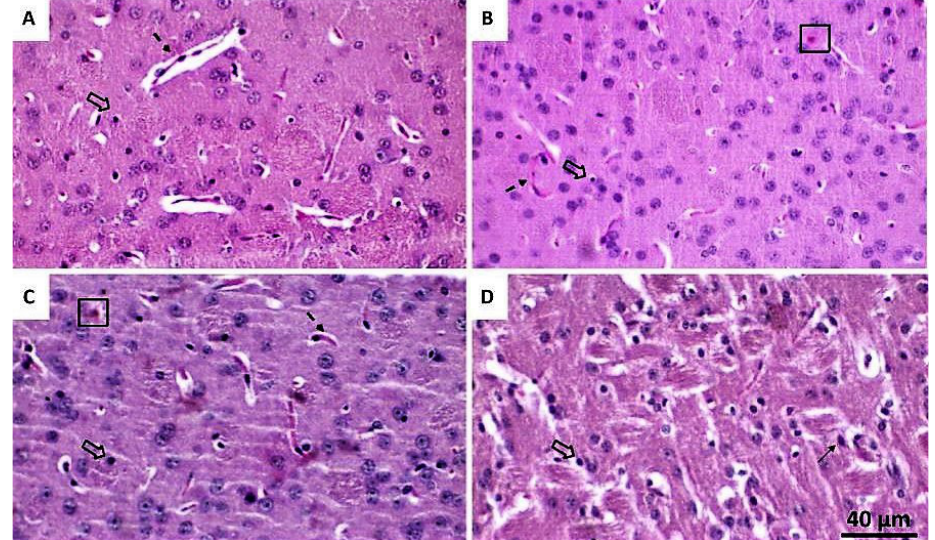
Figure 4. Representative photomicrographs of histological sections stained with Hematoxylin- eosin (HE) showing brain tissue in the striatum—CPu. ( A ) represents the group 6-OHDA/saline; ( B ) represents the group 6-OHDA/ BV 0.01 mg·Kg −1 ; ( C ) represents the group 6-OHDA/ BV 0.05 mg·Kg −1 ; ( D ) represents the group 6-OHDA/BV 0.1 mg·Kg −1 . Dashed arrows point to blood vessels, thick arrows point to oligodendrocytes, squares highlight necrotic neurons and fine arrows point to healthy neuron. Magnification of 400×. The qualitative analysis of TH expression showed that the animals from the 6- OHDA/saline group presented a reduction in the number of positive neurons in the SNc, when comparing the ipsilateral (lesioned) side to the contralateral (control). In groups treated with BV, this effect was not that evident. Instead, both sides were found to be quite similar (Figure 5). The same was noticed regarding the TH-positive fiber density in the CPu (Figure 6).